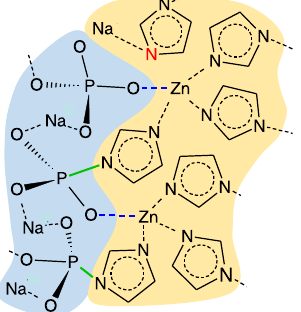
Fig. 10 Potential interface structure. Schematic of the interface between Inorganic glass and MOF glass domains, based on PDF, Raman and